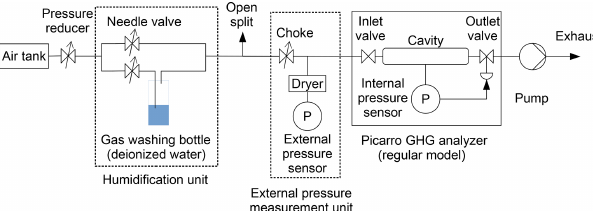
Figure 1. Experimental setup for experiments with stable water va- por levels and external pressure monitoring. Shown here is the setup for a regular Picarro GHG analyzer (Picarro no. 2), from which only pressure data were analyzed. For flight-ready analyzers, the external pressure measurement unit was placed downstream of the analyzer (Fig.